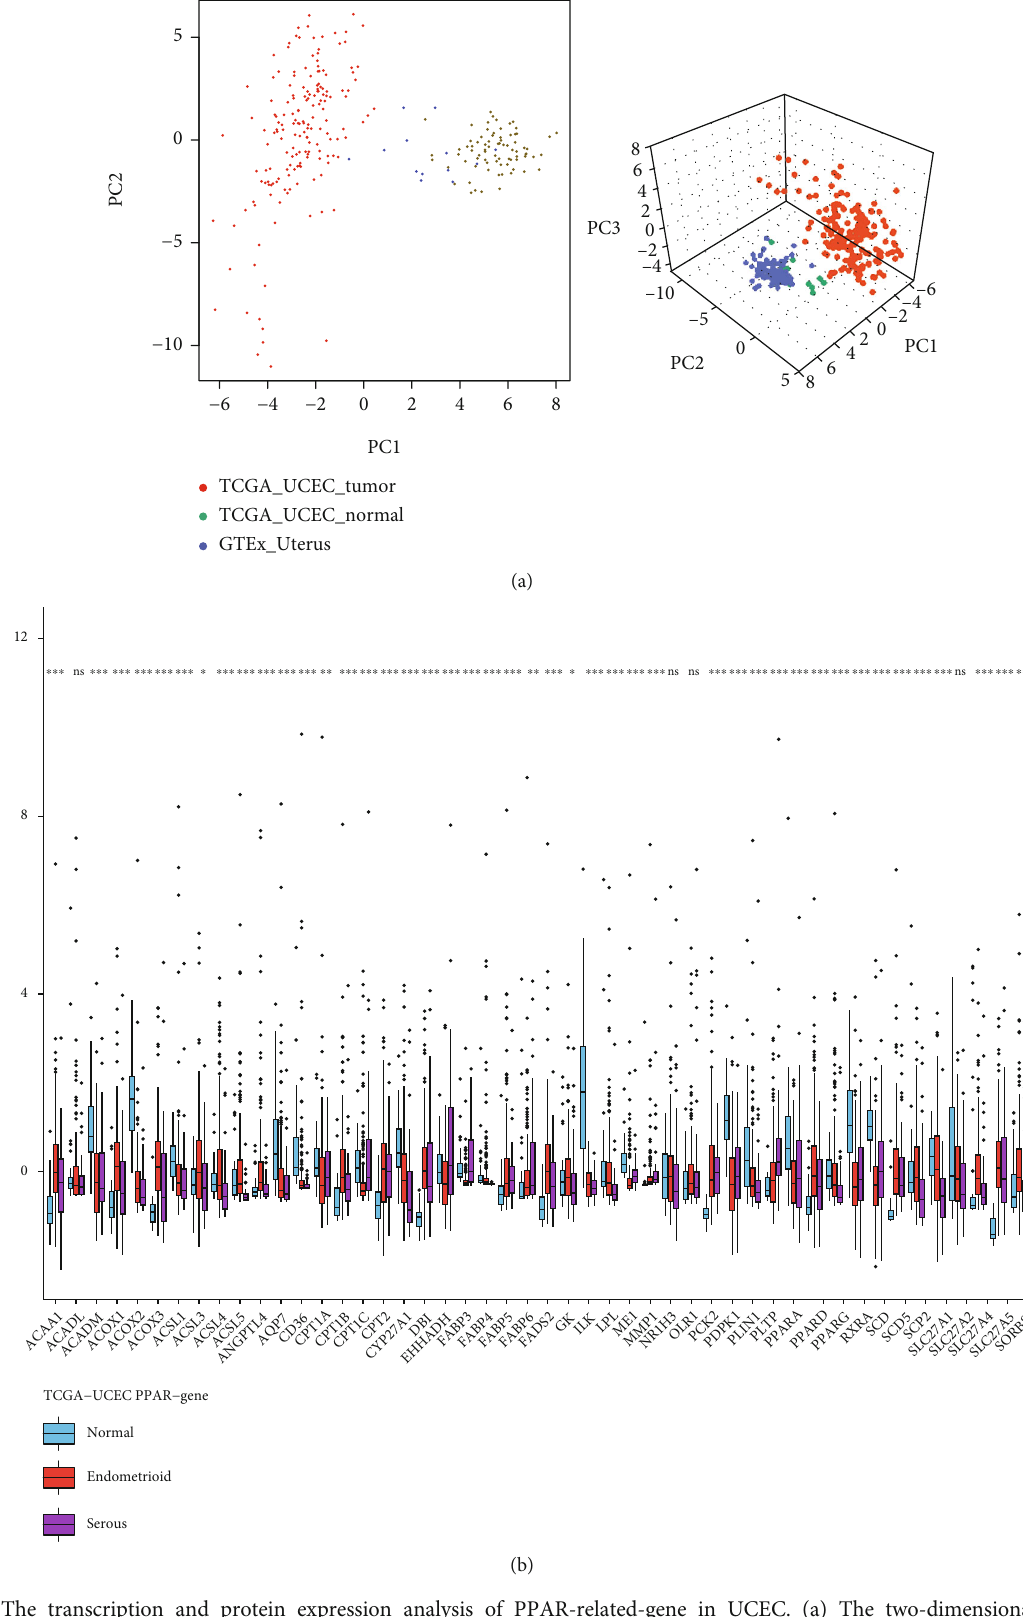
Figure 5: The transcription and protein expression analysis of PPAR-related-gene in UCEC. (a) The two-dimensional and three- dimensional PCA analysis results for PPAR-related-gene transcriptome. (b) The transcription level of each PPAR-related-gene between UCEC para-tumor tissues, endometrioid UCEC, and serous